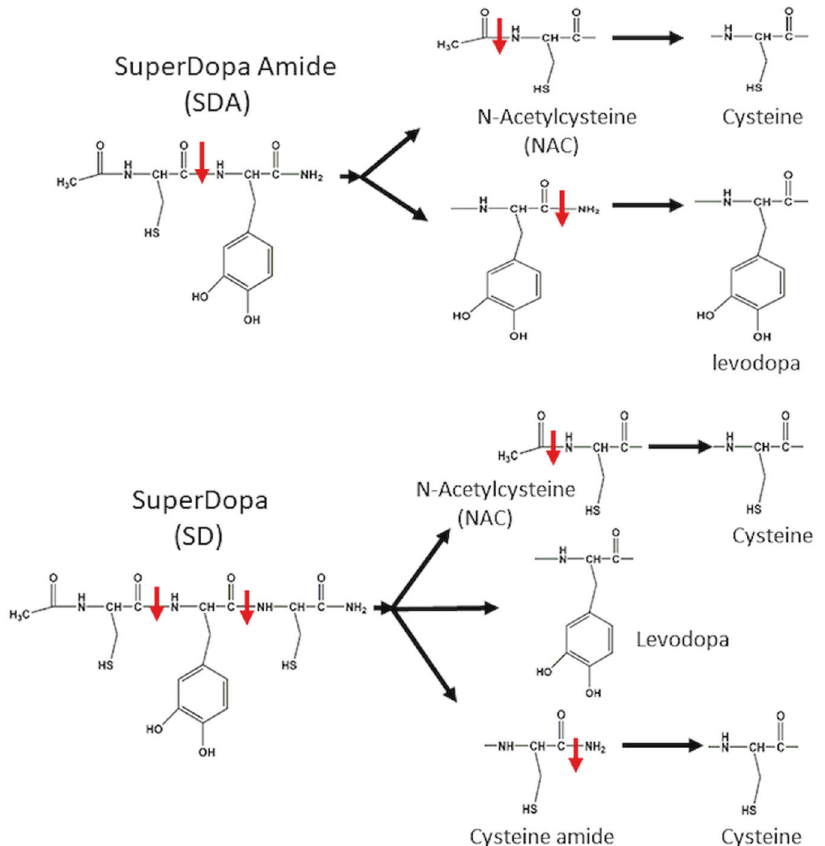
Fig. 1 The structure and putative proteolysis sites of SuperDopa (SD) and SuperDopaAmide (SDA). Upper, putative proteolysis sited for SuperDopa (SD) and lower, putative proteolysis sited for SuperDopaAmide (SDA). The red arrows indicate peptide bond, potential cleavage sites at the peptides